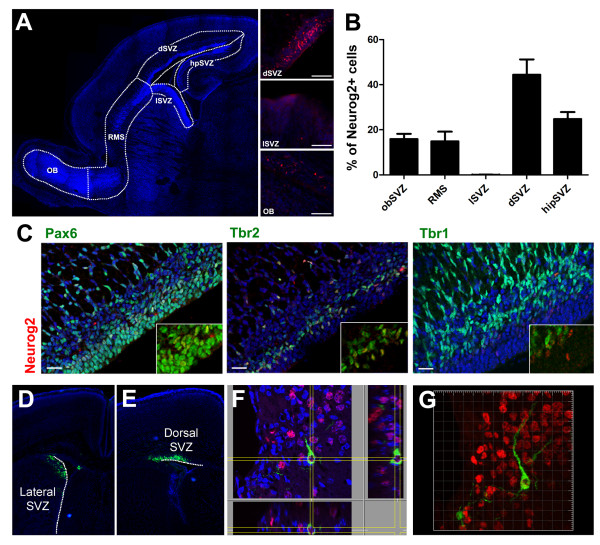
Some glutamatergic periglomerular interneurons are of extrabulbar origin at perinatal ages. (A,B) Distribution of Neurog2 protein throughout the SVZ, RMS and OB. (A) The P0 forebrain SVZ divided into five areas: olfactory bulb SVZ (obSVZ); RMS, also containing the more rostral portion of the lateral ventricle; lateral SVZ (lSVZ); dorsal SVZ (dSVZ, also named subcallosal SVZ); and hippocampal SVZ (hpSVZ). (B) The percentage of Neurog2-positive cells found in each area in a 40-μm thick sagital section from three independent animals. Error bars indicate S.E.M. (C) Co-staining of Neurog2 protein with Pax6, Tbr2 and Tbr1 showing a similar sequential expression of the four markers as observed at earlier developmental stages in the OB. Neurog2 protein shows a strong co-localization with Pax6 and Tbr2, but is down-regulated before Tbr1 expression. (D-G) GFP(+) cells arising from the dorsal SVZ give rise to some Tbr2-expressing juxtaglomerular OB neurons. Electroporation at birth of a GFP plasmid in the lateral (D) and dorsal (E) walls of the lateral ventricles at birth. (F,G) Only the dorsal electroporated animals show some Tbr2-positive juxtaglomerular neurons 12 days later, illustrating the extrabulbar origin of some OB glutamatergic juxtaglomerular neurons. Scale bars: 100 μm in (A, inserts); 20 μm in (C).